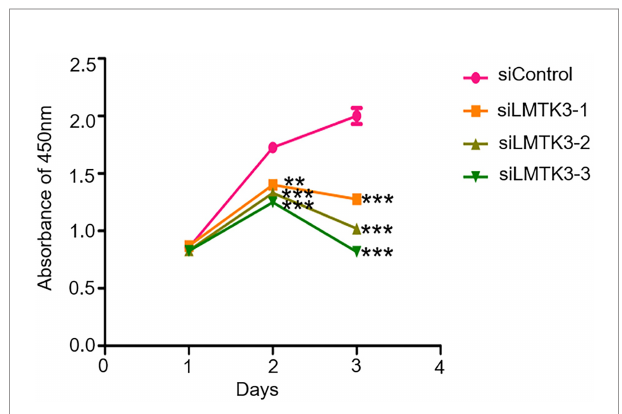
FIGURE 2 | Effects of LMTK3 knockdown on cell viability in Ishikawa cells by CCK-8 (n=3, ** P < 0.01, *** P <